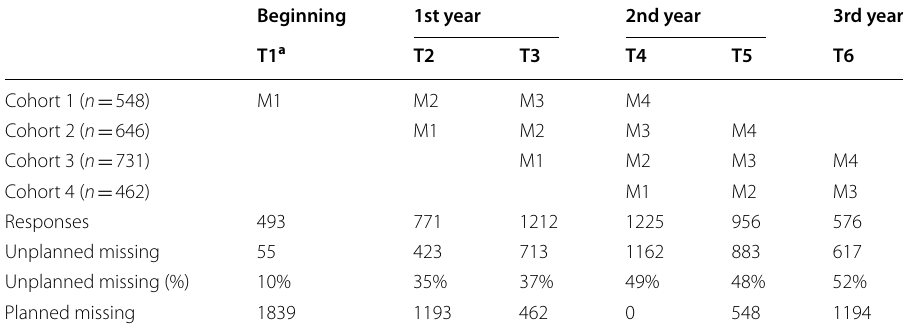
Table 1 Cohort sample size, measurement timepoints and